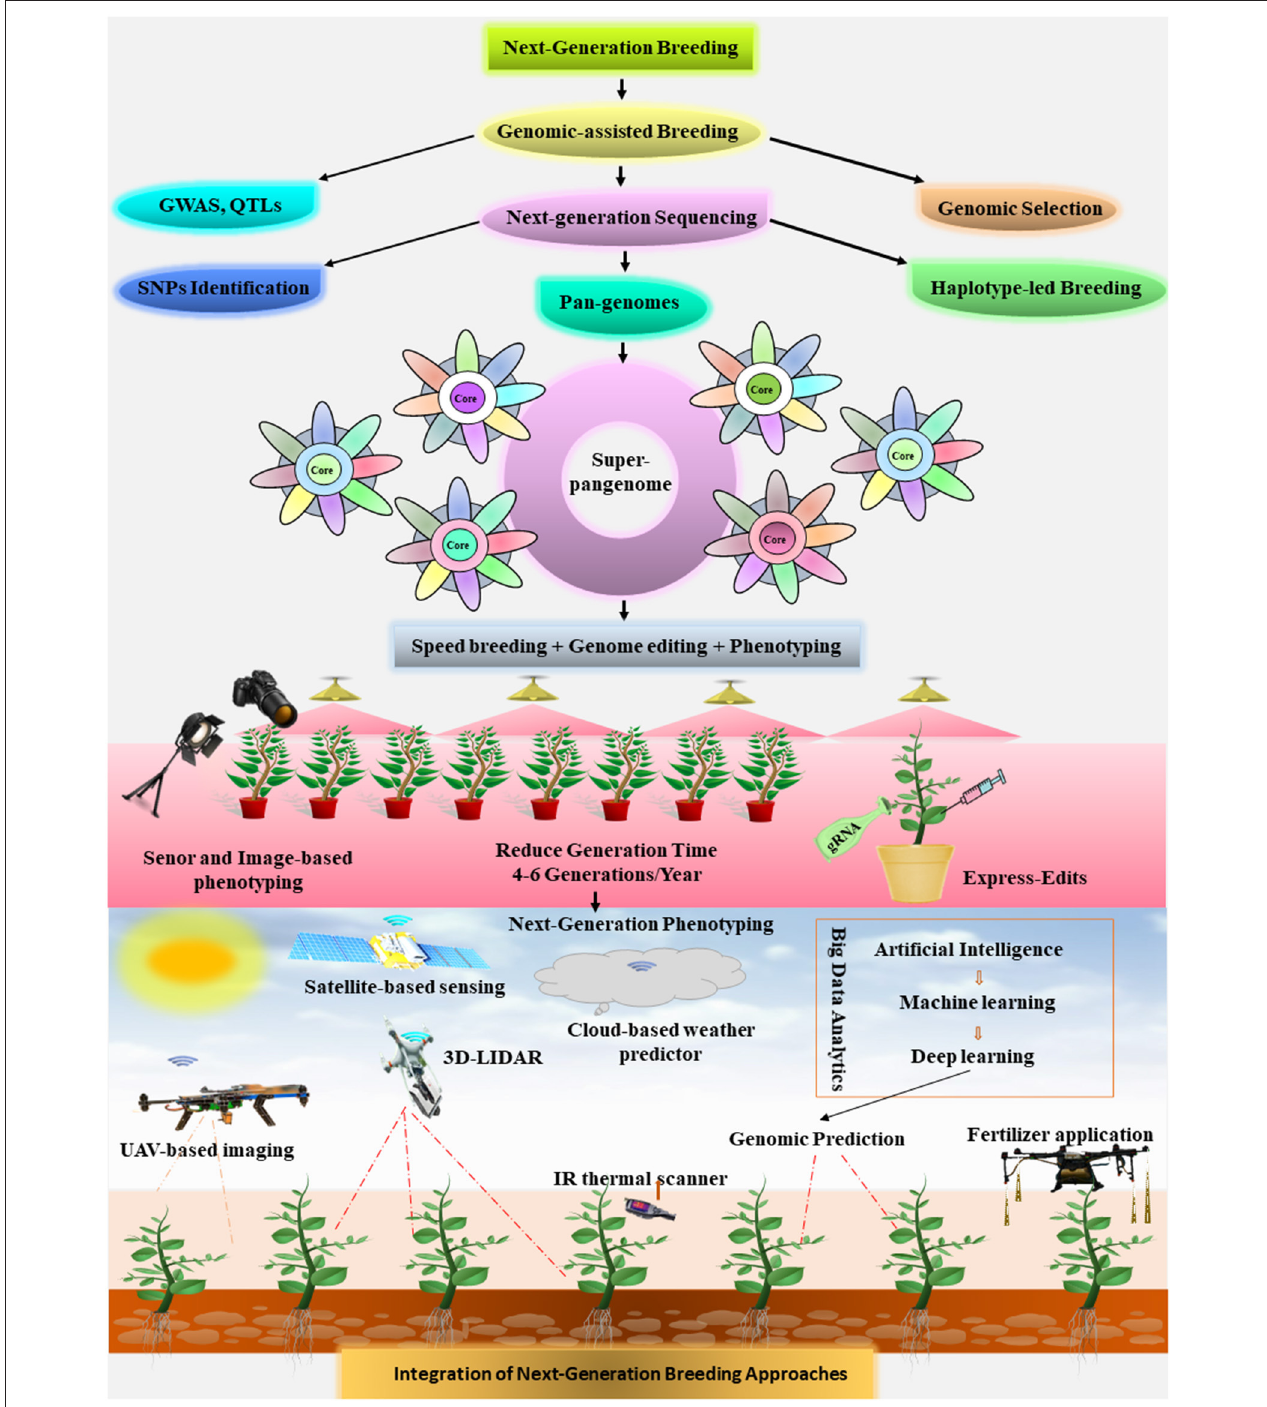
FIGURE 7 | Integration of next-generation breeding pipelines for crop improvement.